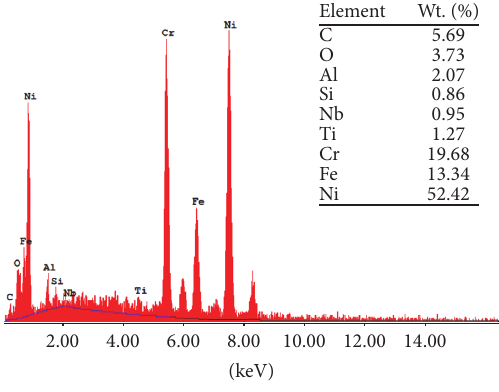
Figure 2: EDAX profile of Inconel 718.